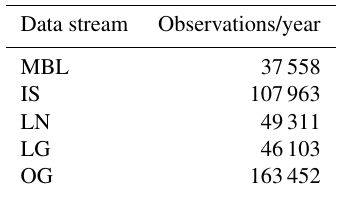
Table 2. Number of pseudo-observations per year from the different observing systems and sampling